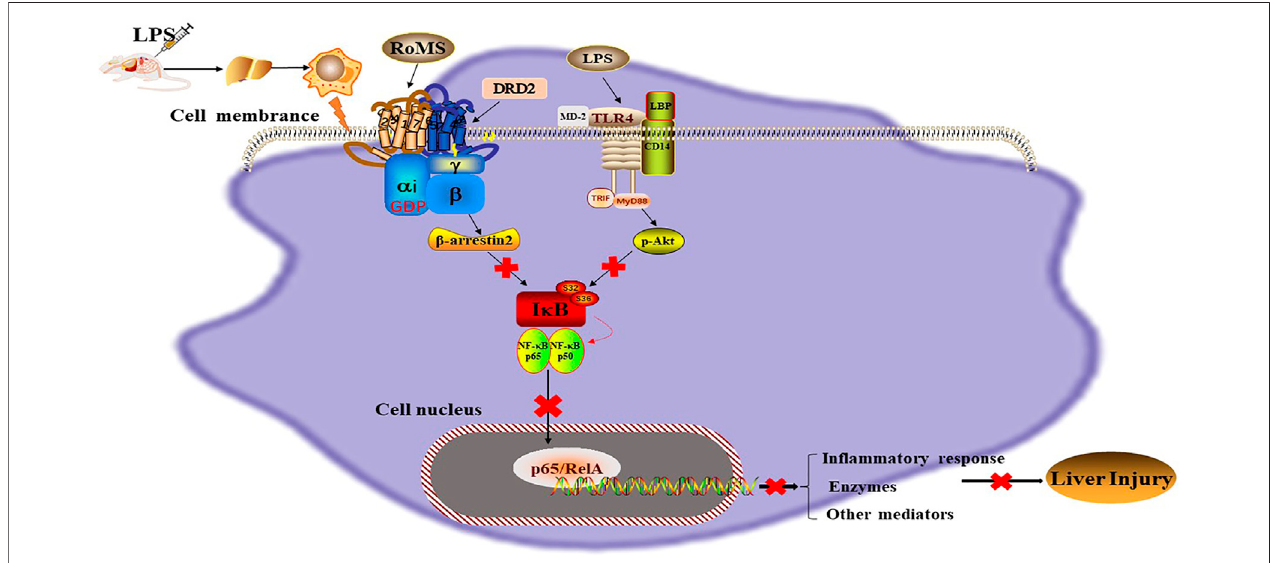
FIGURE 7 | Mechanism of RoMS in immune-mediated liver injury. LPS binds to TLR4 on the surface of hepatic Kupffer cells and promotes the phosphorylation levels of Akt, I κ B α and NF- κ Bp65, which drives NF- κ Bp65 into the nucleus to regulate the transcription of target genes. This can induce excessive in fl ammatory responses and secretion of multiple pro-in fl ammatory cytokines. The results show that RoMS can activate DRs on the surface of hepatic Kupffer cells and negatively regulate the Akt/NF- κ B pathway through a β -arrestin2-dependent mechanism, thereby attenuating LPS-induced in fl ammatory liver injury. RoMS: Rotigotine extended-release microspheres; LPS: Lipopolysaccharide; TLR4: Toll-like receptor 4; MD2: myeloid differentiation 2; TRIF: TIR domain-containing adapter inducing interferon- β ; LBP: LPS binding protein; I κ B: Inhibitor of kappa B; NF- κ Bp65: Nuclear factor-kappa B; GDP: Guanosine diphosphate; β -arrestin2: β -inhibitor protein 2; Akt: Protein kinase B; MyD88: Myeloiddifferentiationfactor88.